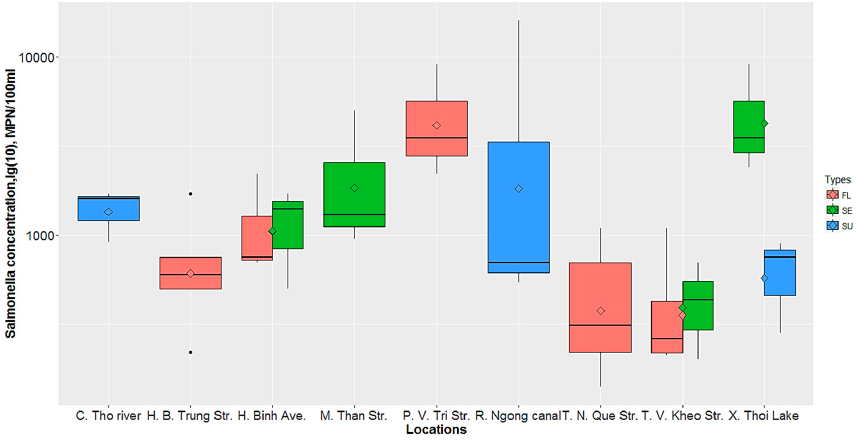
Figure 6. Box plot of Salmonella during the flood event among water bodies at different locations (SU: Open/Surface water, SE: Sewer water, FL: Flood water; the diamond symbols representing average values).